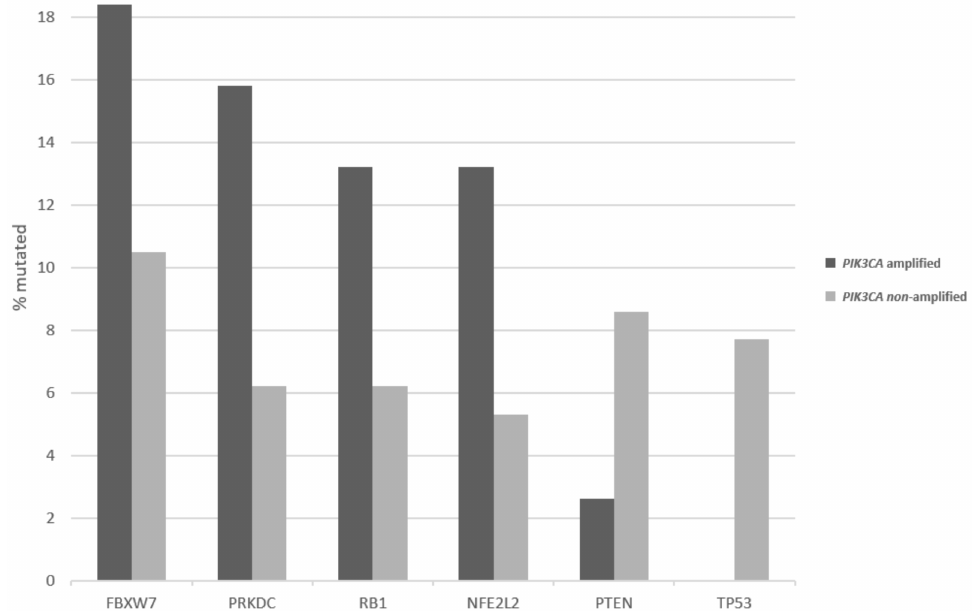
Figure 3. Percentage of mutations in the most common squamous cervical cancer-associated genes in cervical cancers with and without 3q26 amplifications. Data are derived from the TCGA cervical cancer cohort.